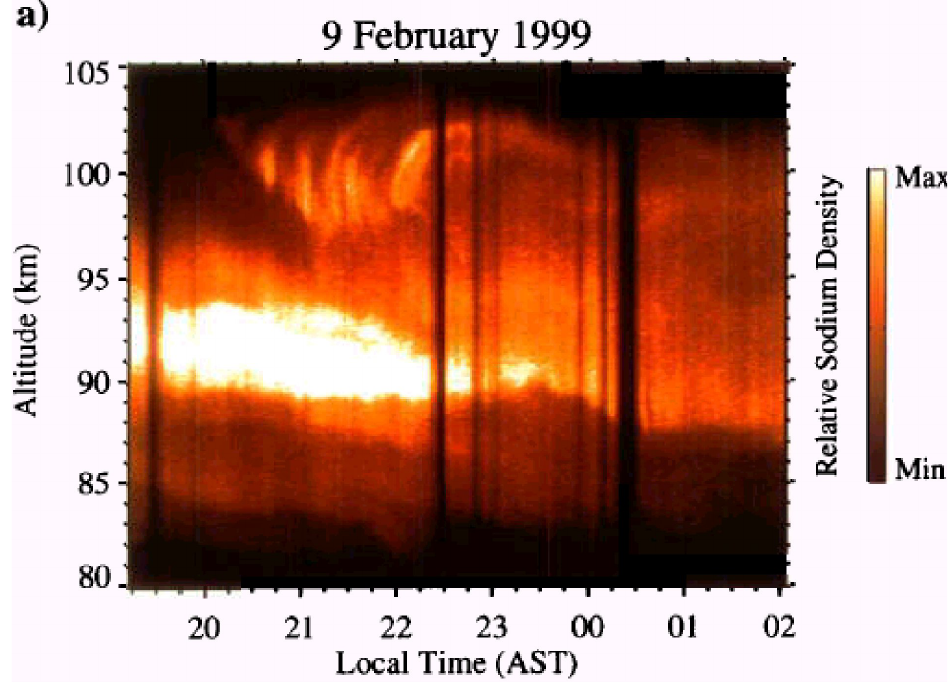
Fig. 6. Atmospheric sodium distribution observed at Puerto Rico (18 ◦ N) showing the presence of C-structures (after Kane et al.,